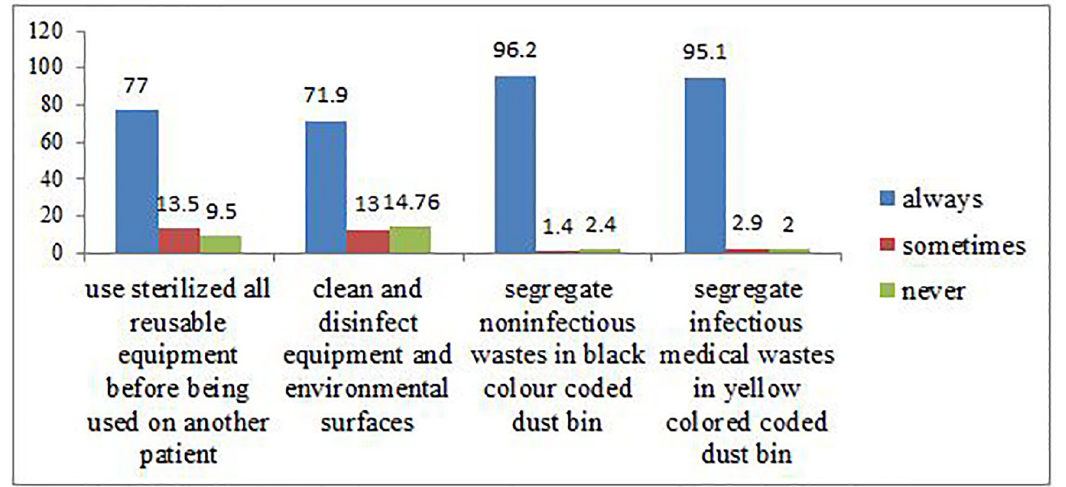
Fig 1. Frequency of healthcare waste management within HCWs in Hawassa comprehensive specialized hospital.